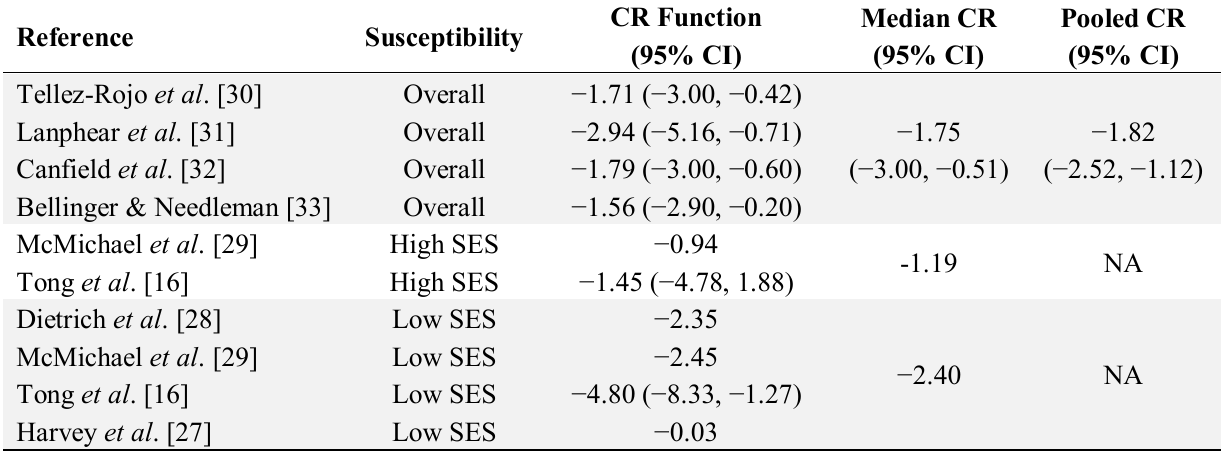
Table 3. Individual and combined concentration-response functions at 2 µg/dL blood lead level.